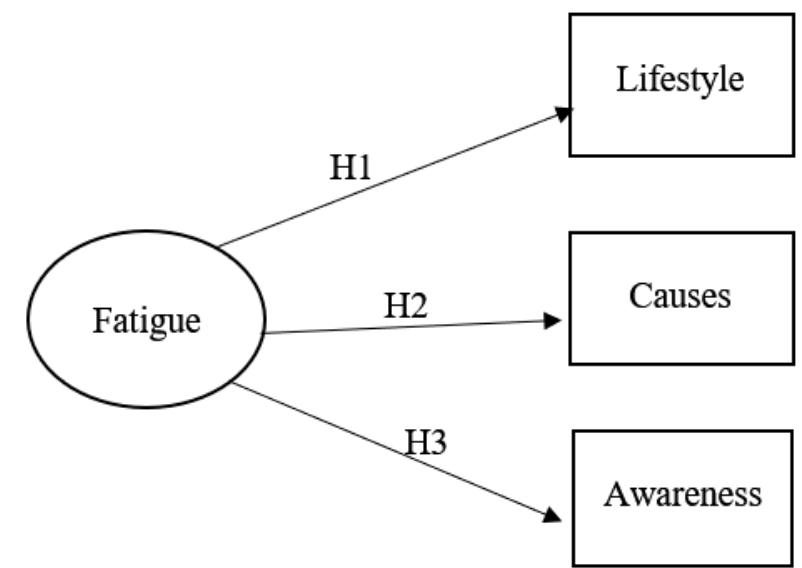
Figure 2. Hypothesized Measurement Model of Fatigue in Collegiate Aviation.